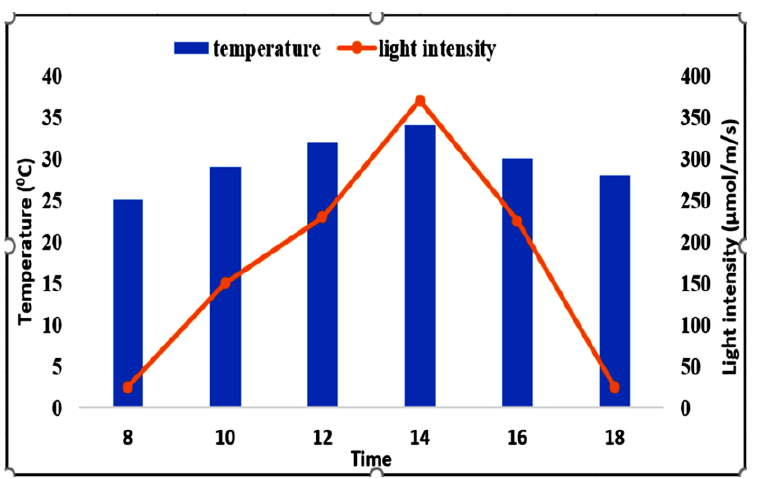
Figure 17. Temperature and light intensity fluctuation in the glasshouse. Note: The temperature was measured using a thermometer and light intensity was measured by a heavy-duty light meter (Extech ® model 407026).